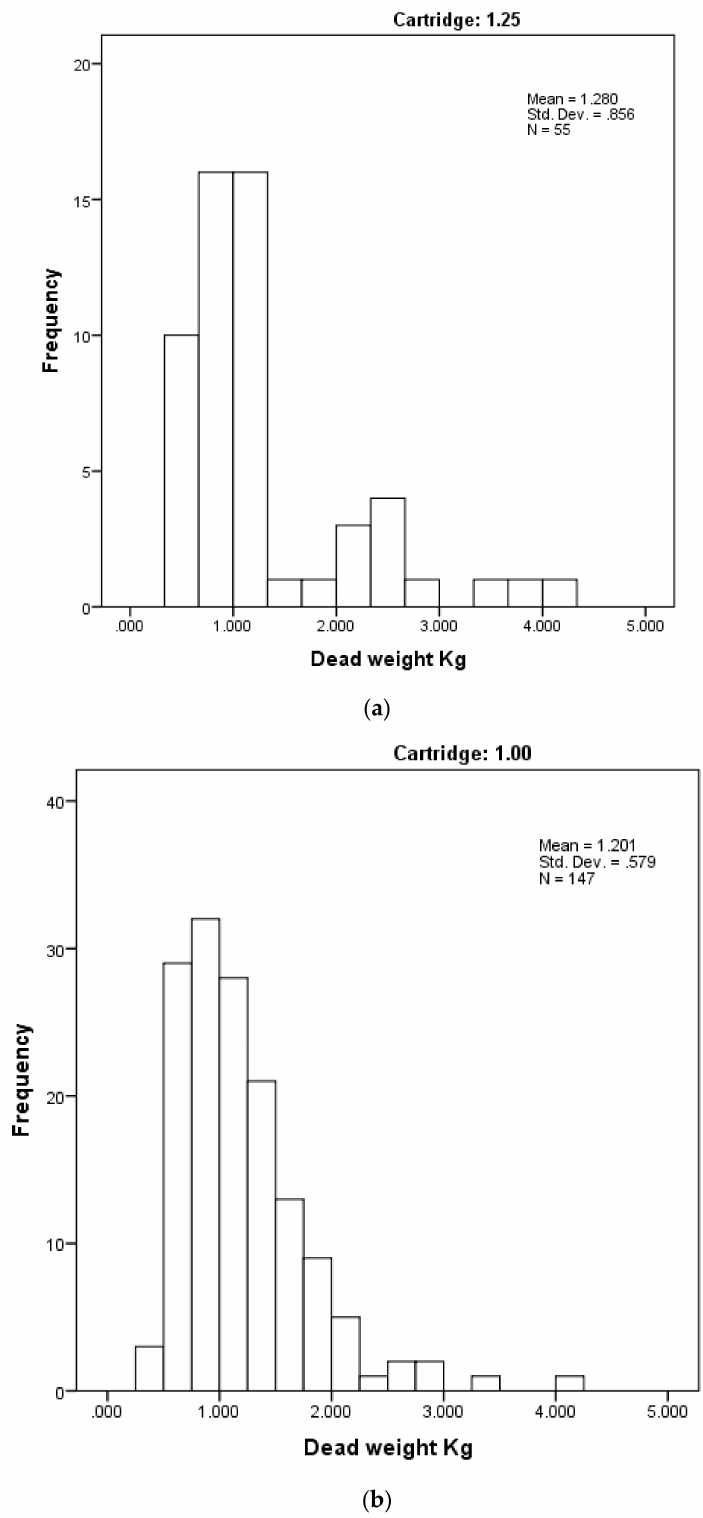
Figure 8. Distribution of piglet dead weights (kg) by cartridge used. ( a ) with 1.25 grain cartridge and ( b ) with 1 grain